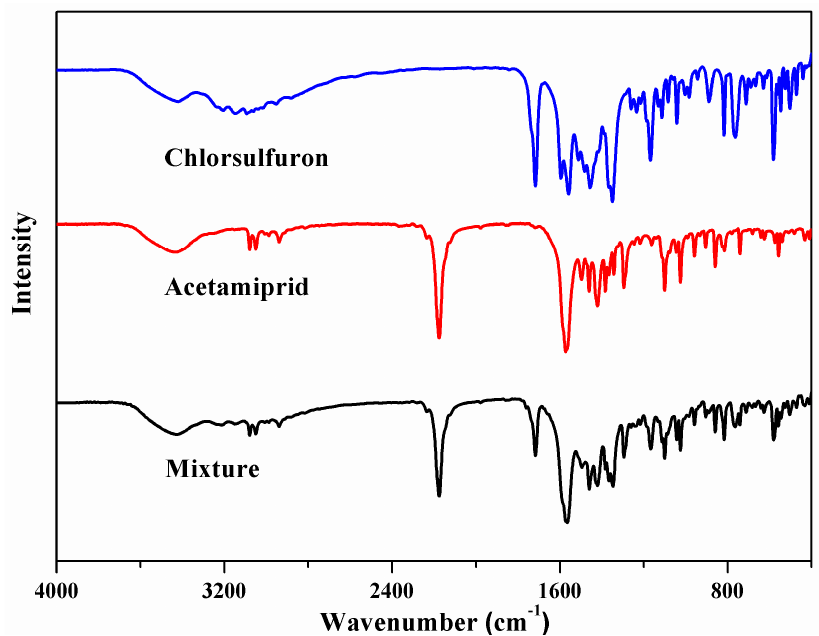
Figure 3. FT-IR spectra of: chlorsulfuron, chlorsulfuron, the complex of acetamiprid and chlorsulfuron.